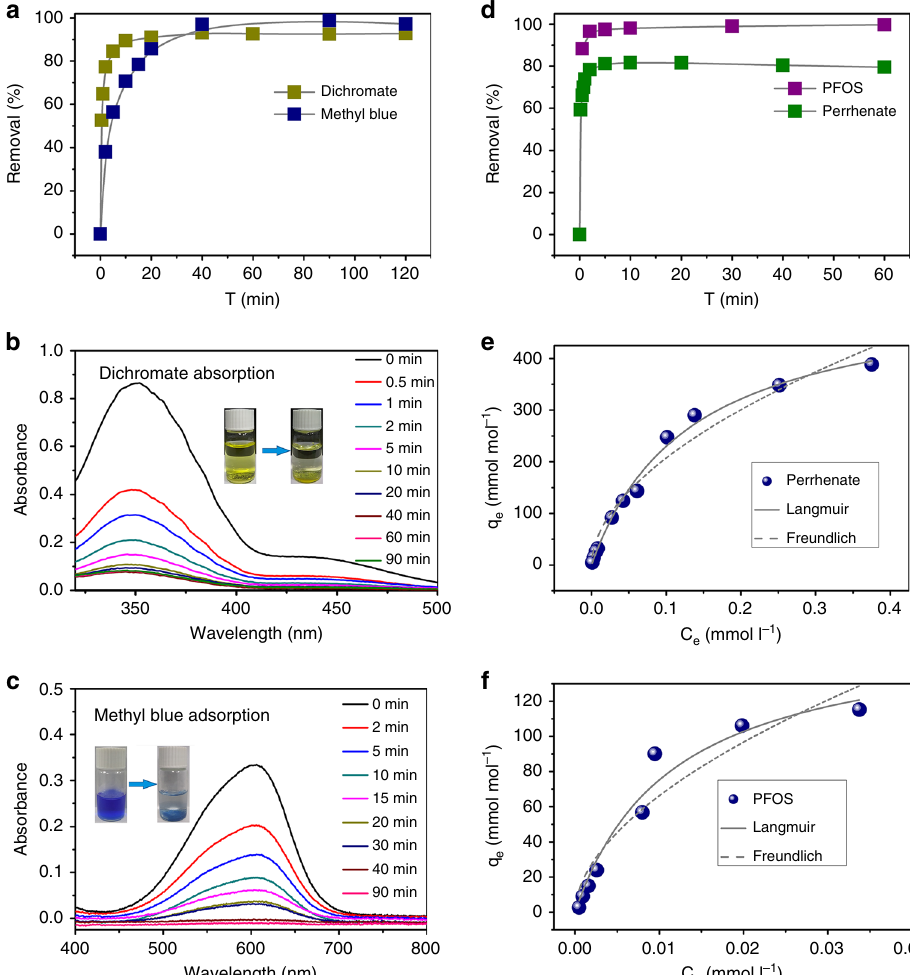
Fig. 3 Anion-exchange experiment results. a Sorption kinetics of Cr 2 O 7 2 − and MB 2 − on SCU-8; b Sorption kinetics of ReO 4 − and PFOS on SCU-8; c , d UV/ Vis absorption spectra of the solutions during the Cr 2 O 7 2 − and MB 2 − uptake processes; e , f The sorption isotherms of ReO 4 − and PFOS by